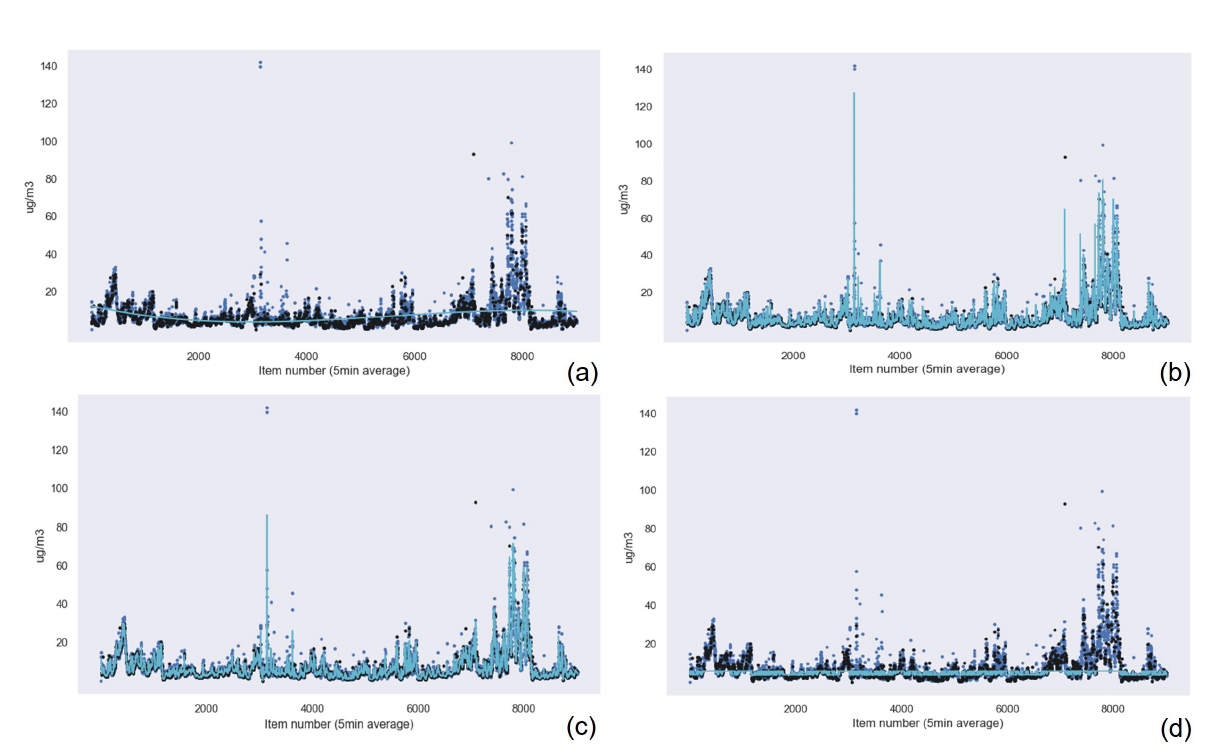
Figure A14. Humidity results of the articulate matter measuring device # 1 with outliers for ( a ) Linear Regression ( b ) Random Forest Regression ( c ) KNN and ( d ) Support Vector Machine, and without outliers for ( e ) Linear Regression ( f ) Random Forest Regression ( g ) KNN and ( h ) Support Vector Machine.